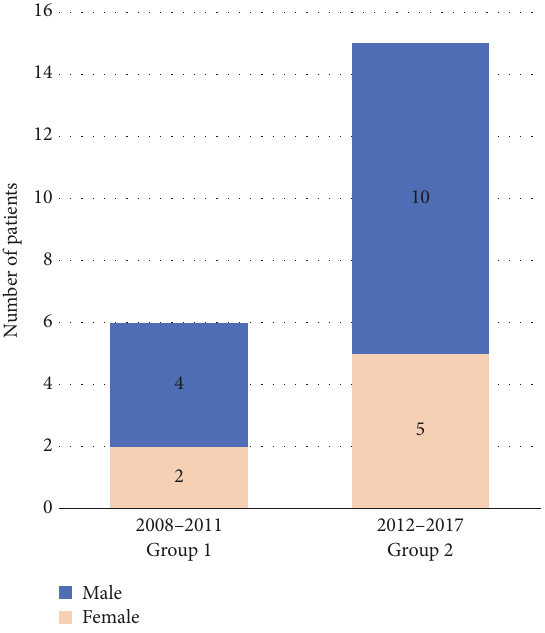
Figure 1: Groups 1 and 2 with respect to gender and years.